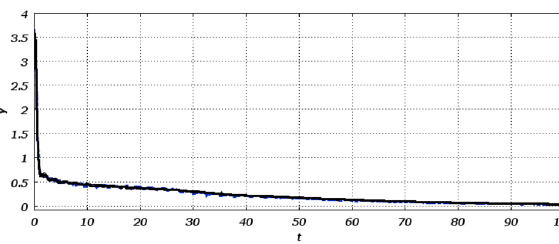
Fig. 4 Polynomial decay: y = E ( t )( 1 + t ) 2 / 3